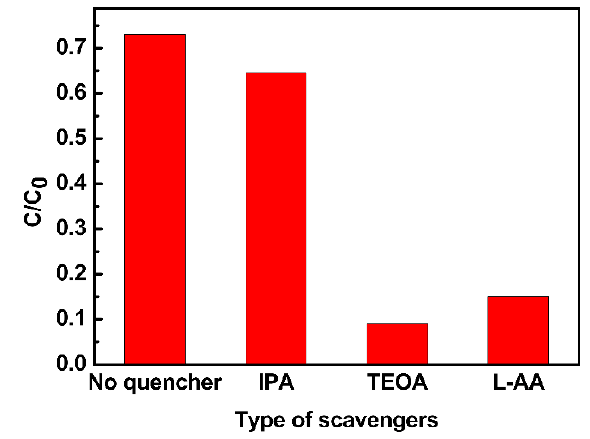
Figure 7. Trapping experiment of the active species.